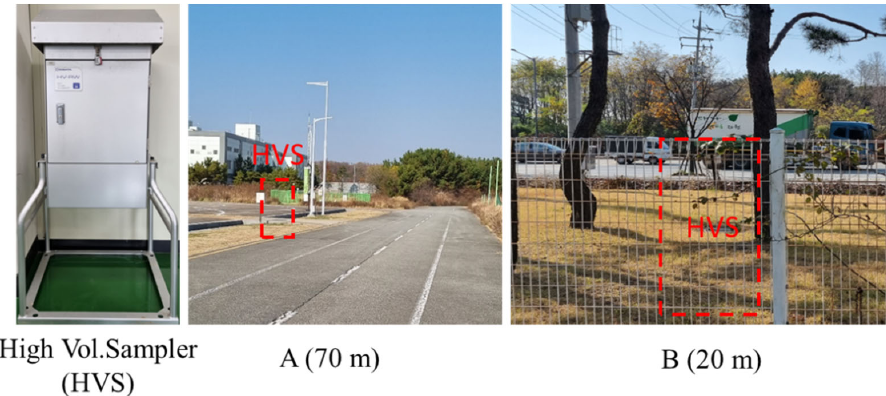
Figure 2. High-volume sampler (HVS) and spots where the HVSs were placed for sampling the total suspended particles in the environment.